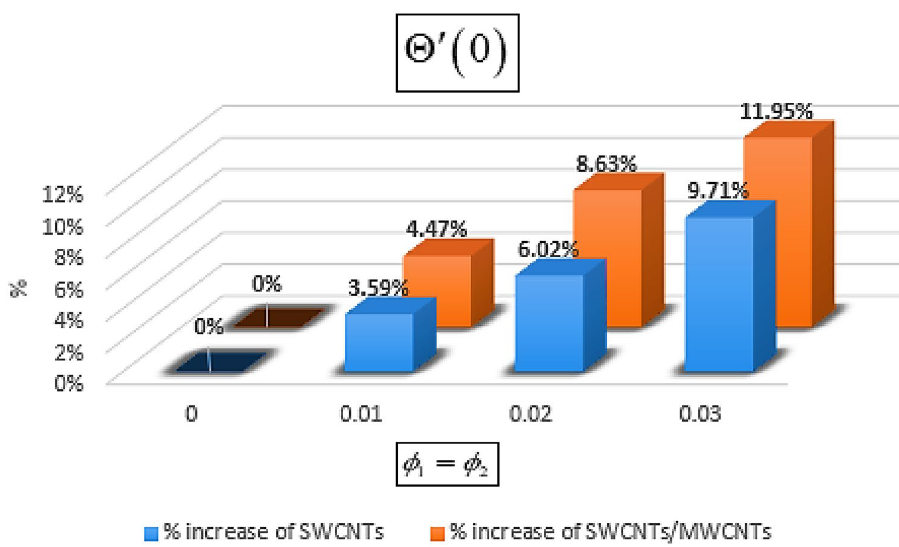
Figure 23. % enhancement in the heat transfer rate.